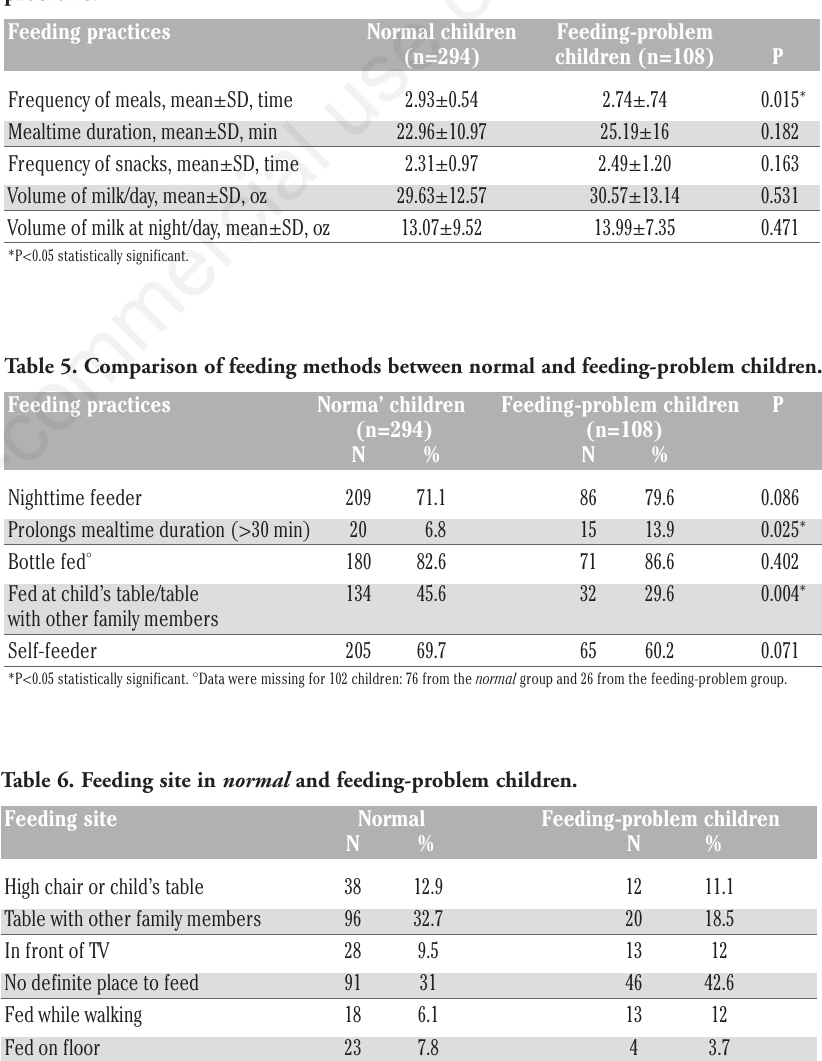
Table 4. Feeding practices in normal children compared with children with feeding problems.